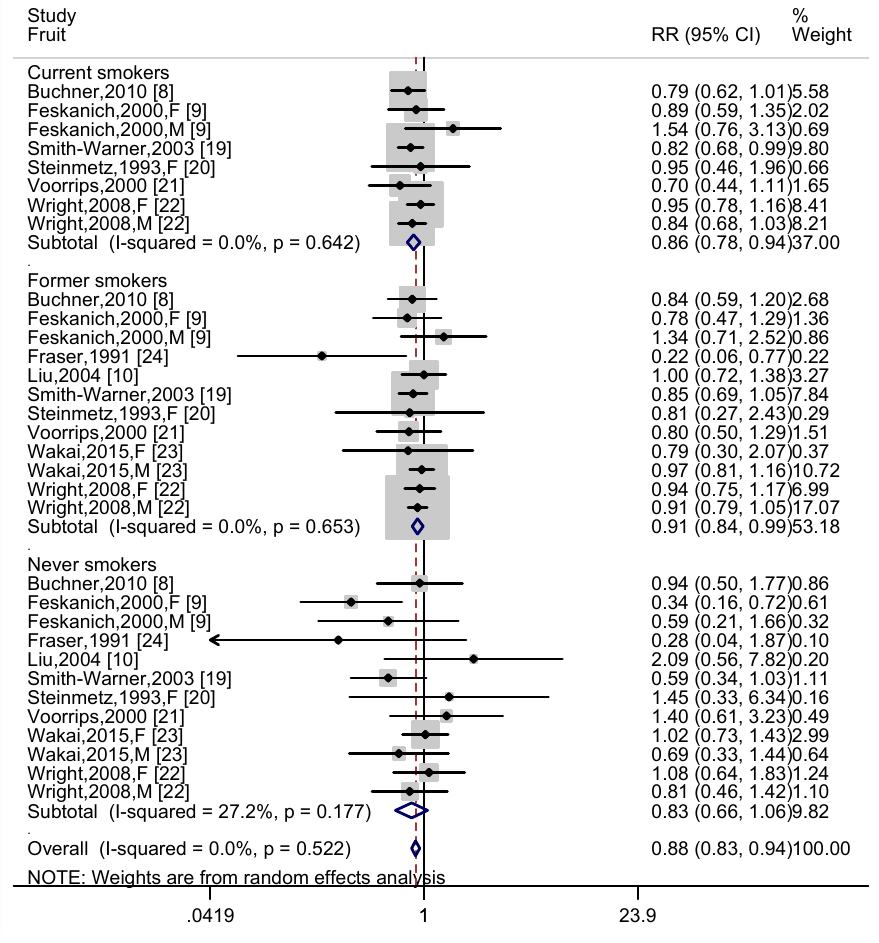
Figure 2. Differences in fruit composition between current smokers, former smokers and never smokers. The pooled effect was calculated using a random-effects model. The diamonds denote summary risk estimate, and horizontal lines represent 95% CI. Abbreviations: F—female; M—male; RR—relative risk.